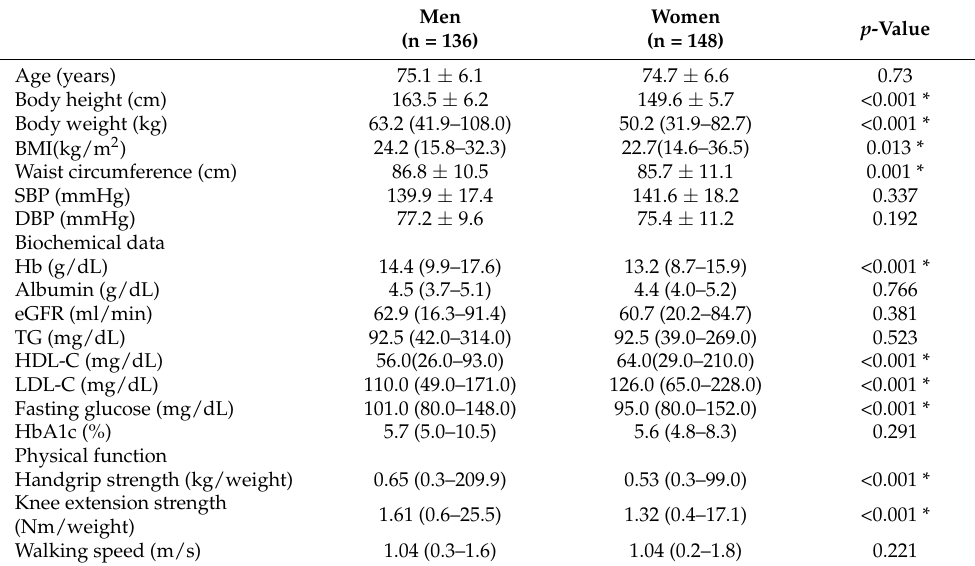
Table 1. Characteristics of study participants.